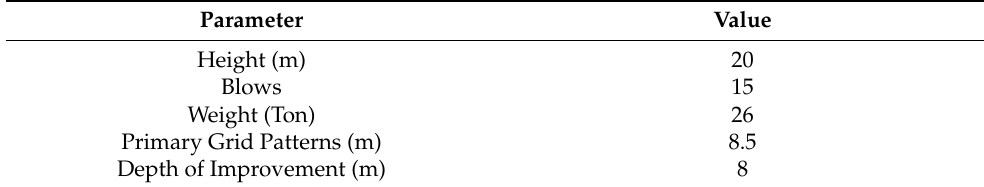
Table 4. DC implementation parameters of the case study.